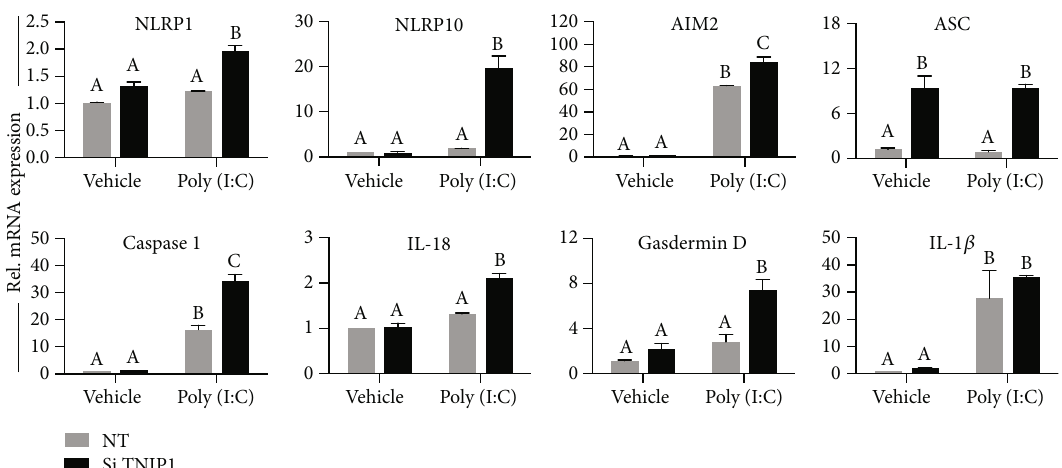
Figure 4: Upregulated gene expression of pyroptosis-associated markers with TNIP1 de fi ciency and poly (I:C) treatment. Gene expression changes were measured from RNA isolated 6hr post-poly (I:C) (1 μ g/mL) treatment of TNIP1-de fi cient HaCaT keratinocytes. mRNA levels were measured by qRT-PCR, normalized to RPL13a, and shown as fold change relative to siRNA negative control and vehicle- treated cells (NT). Data is presented as mean + SEM from two independent experiments. Means with a common letter are not signi fi cantly di ff erent by two-way ANOVA followed by Tukey ’ s post hoc test at a signi fi cance level of p ≤ 0 : 05